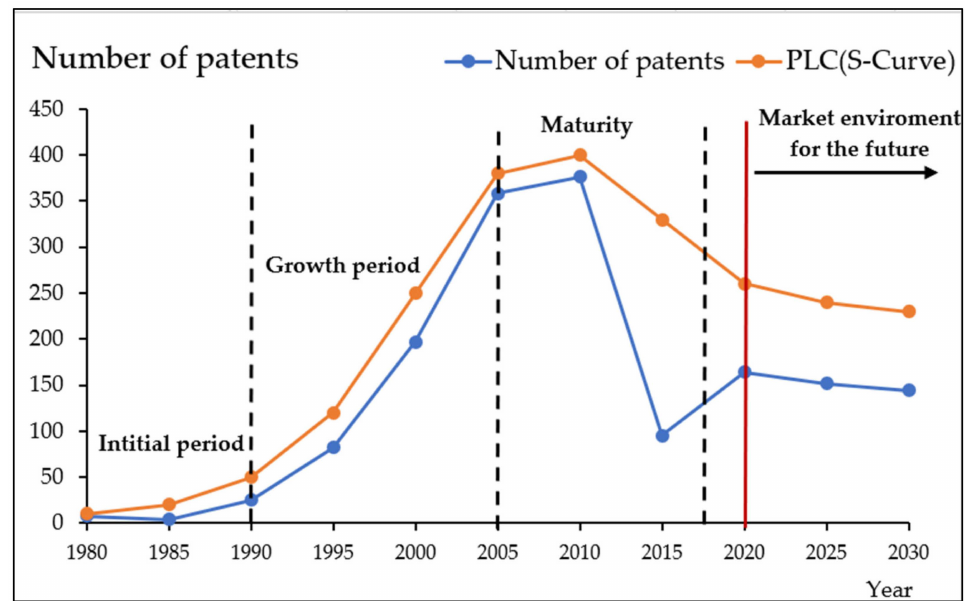
Figure 10. Comparison of patent quantity and S-shaped